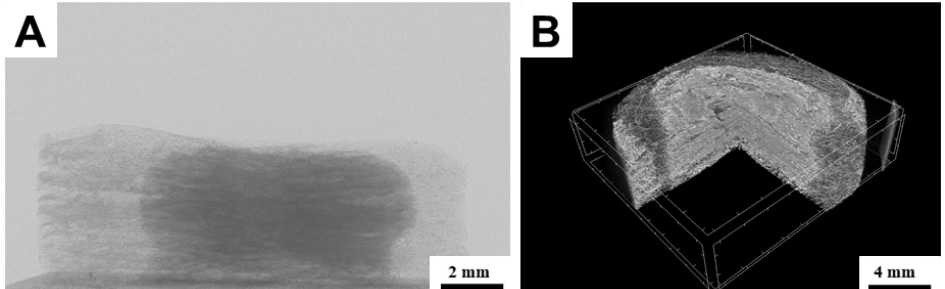
Figure 11. Computed tomography images visualizing the distribution of hydrogel within a scaffold structure. ( A ) ‐ side view of the sample; X ‐ ray scan. ( B ) ‐ 3D sample screening.